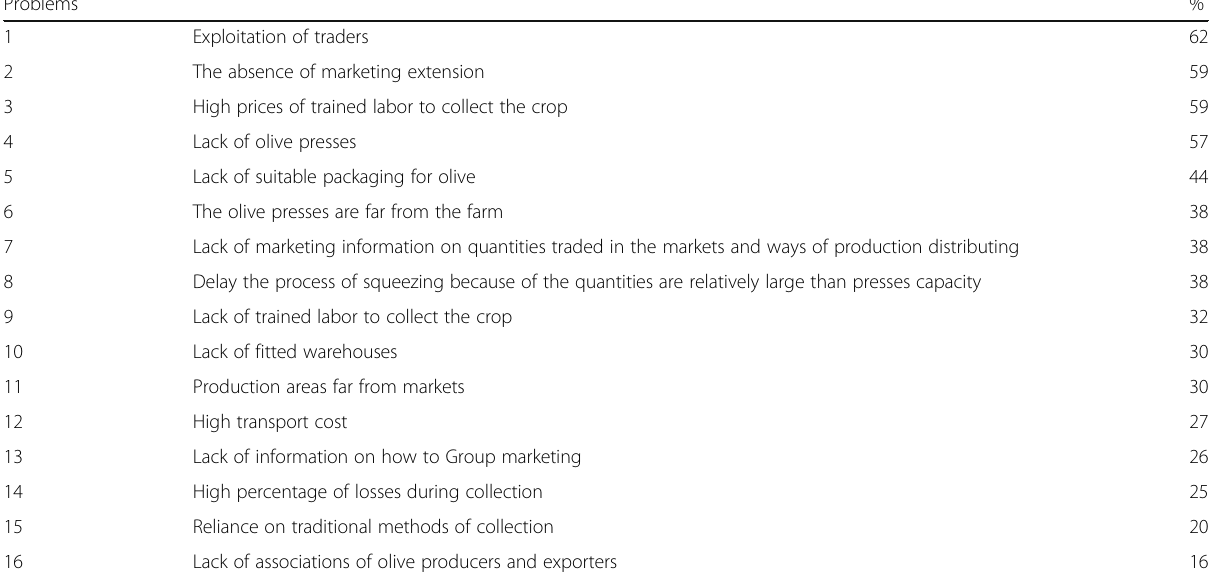
Table 4 Marketing problems facing olive